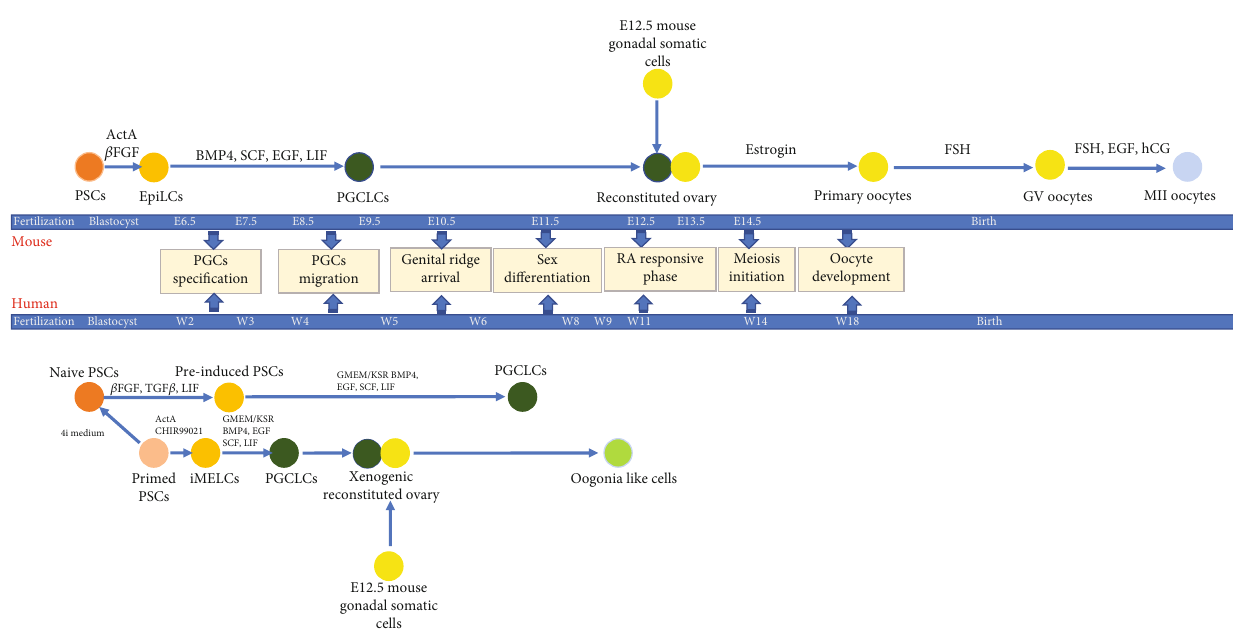
Figure 3: Schematic of the reconstitution of mouse and human female germ cells in vitro . Mouse and human female germ cell inductions are described in the upper and lower panel. In vitro -induced cells are represented with coloured